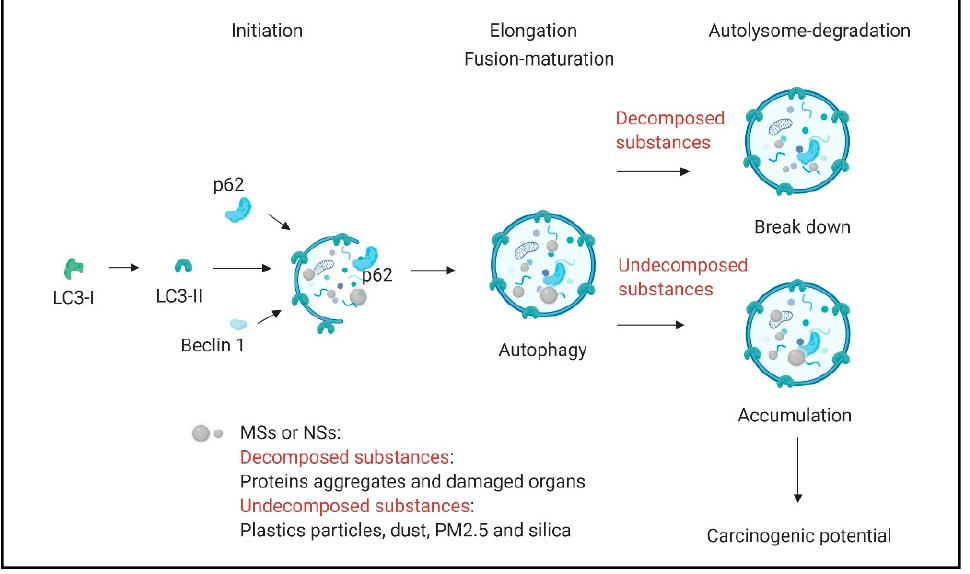
these micro- and nanoparticles interfere with the function of EVs is still unclear.